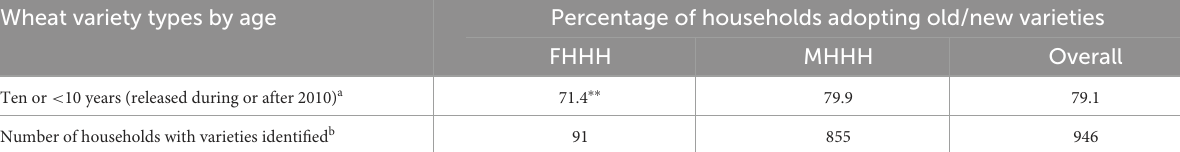
TABLE 3 Comparison of age of varieties used by male- and female-headed households. Wheat variety types by age